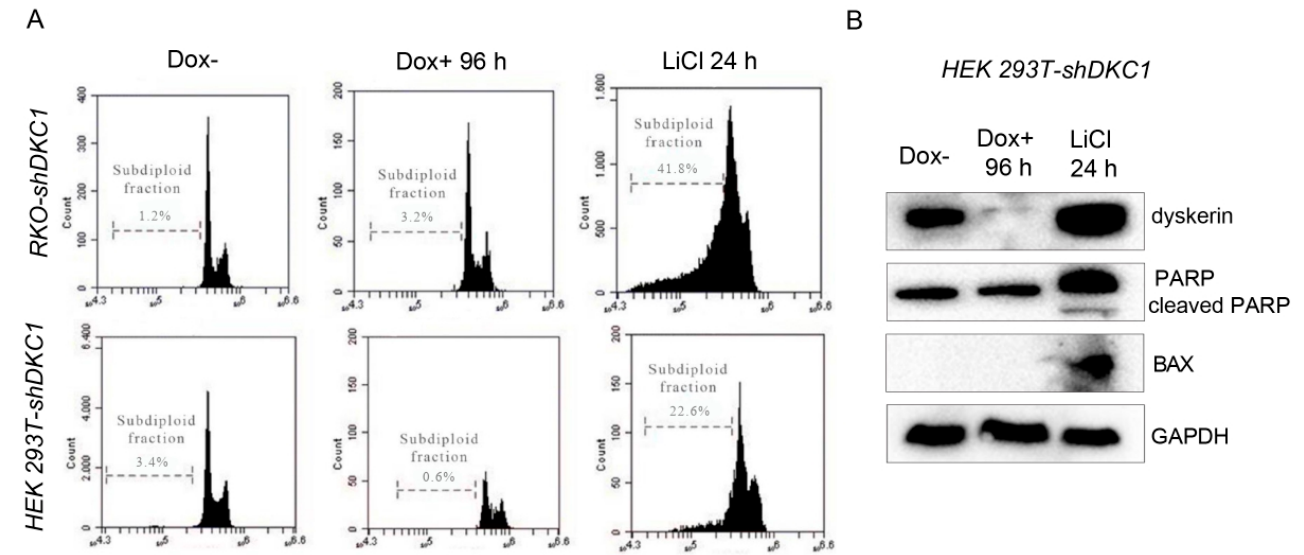
Figure 3. Dyskerin depletion does not activate apoptosis. ( A , B ) Induction of apoptosis was measured by calculating the percentage of control (Dox–) and silenced (Dox+) cells displaying subdiploid DNA content following propidium iodide staining. As a positive control, RKO-shDKC1 and HEK 293T-shDKC1 cells were treated for 24 h with LiCl (60 mM), an inducer of apoptosis. ( C ) Western blot analyses of the apoptotic markers PARP and BAX in control (Dox–), dyskerin-depleted cells (Dox+ 96 h), and control cells treated with LiCl (60 mM) for 24 h; the latter served as a positive control. Collectively, the above findings indicate that ERS caused by dyskerin depletion does not activate apoptosis, at least not after 96 h of DKC1